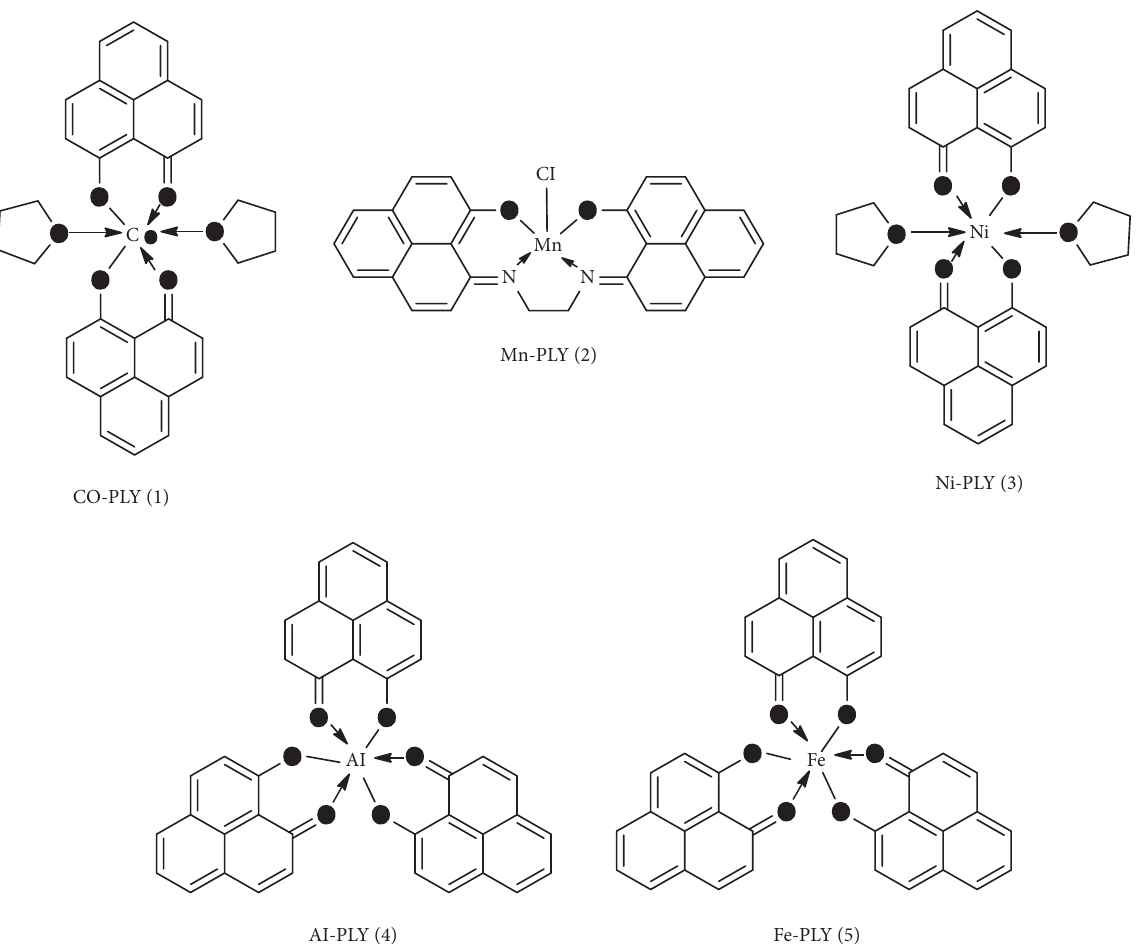
Figure 1: Structures of the metal-PLY